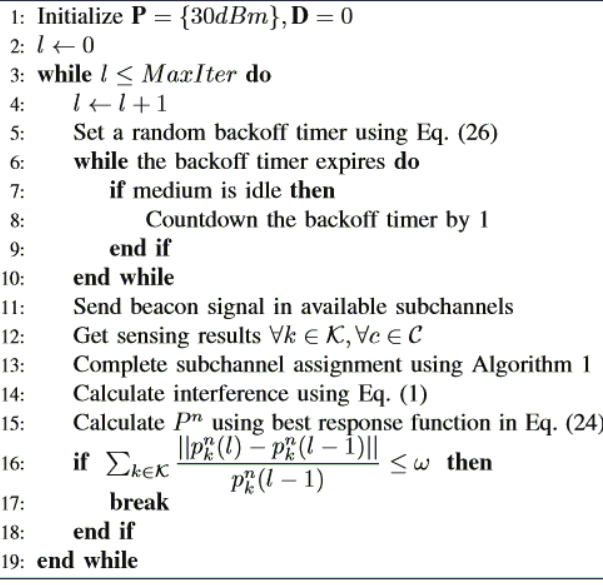
Figure 5. Simultaneous iterative water-filling algorithm (SIWA) for each BS n ∈ N